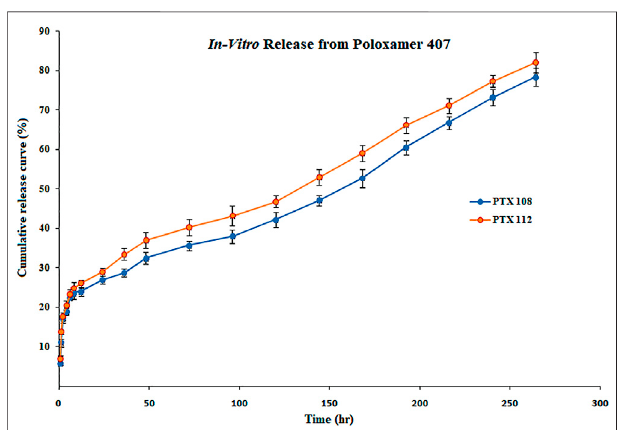
FIGURE 5 | In vitro release pro fi le of paclitaxel from nanoformulations of poloxamer 407.